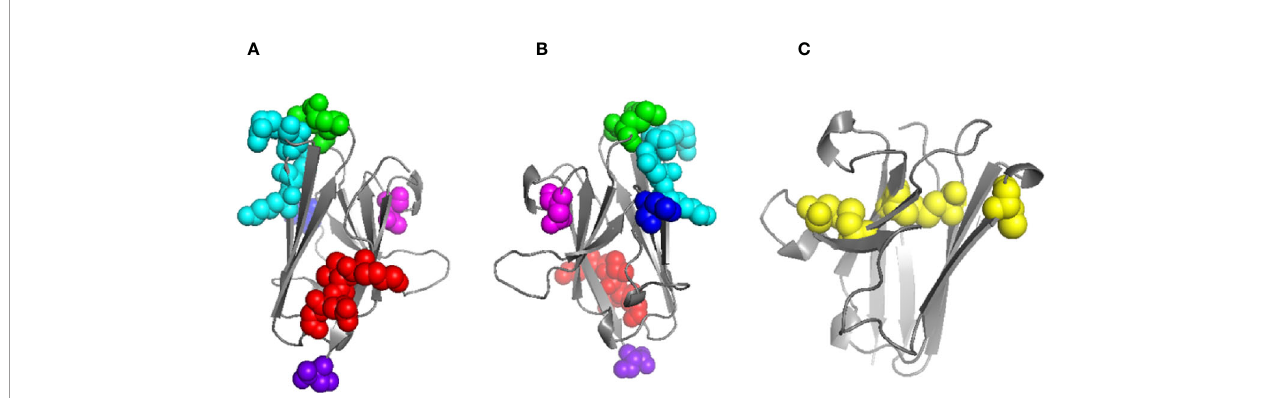
FIGURE 5 | Models of human and mouse FcµR Ig-like domains. Model of human FcµR domain (A) and horizontally rotated by 180° (B) indicating the residues mutated in this study: K24-G27 (red), E41/M42 (green), N66 (blue), K79-R83 (cyan), N109 (magenta); the C-terminus is also indicated (purple). Model of mouse FcµR domain (C) showing all fi ve C residues; four form two disulphide bridges (left and center) and the single free C residue at position 81 is shown exposed on the right. Models were generated using Swiss-Model (18).